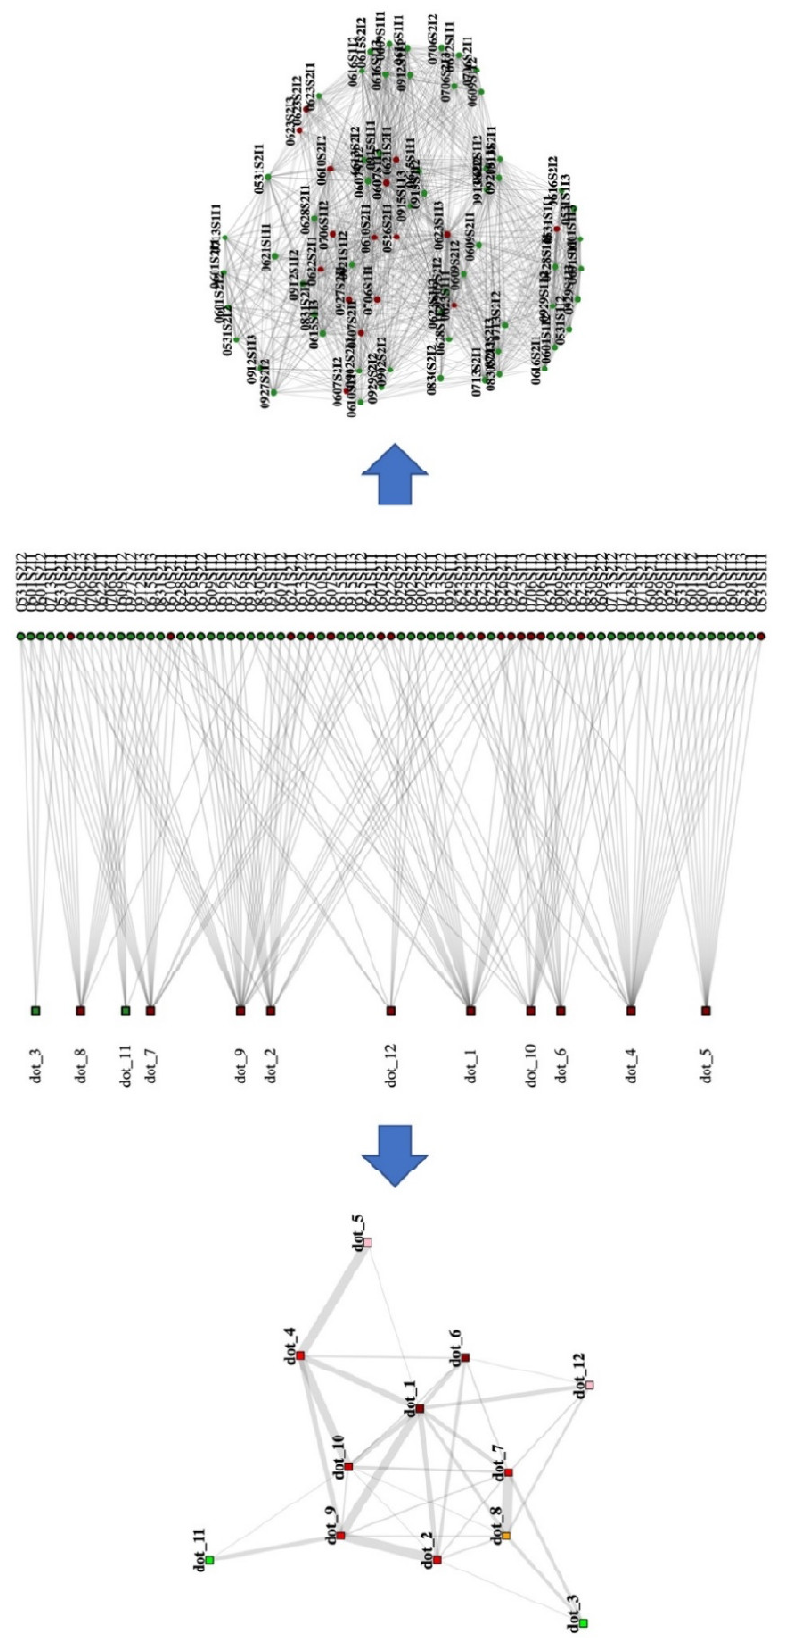
Figure A1. The two-mode starting network (central network), the top one-mode projection of doctor interactions ( top ), and the bottom one-mode projection of the surgery rooms interactions ( bottom ).